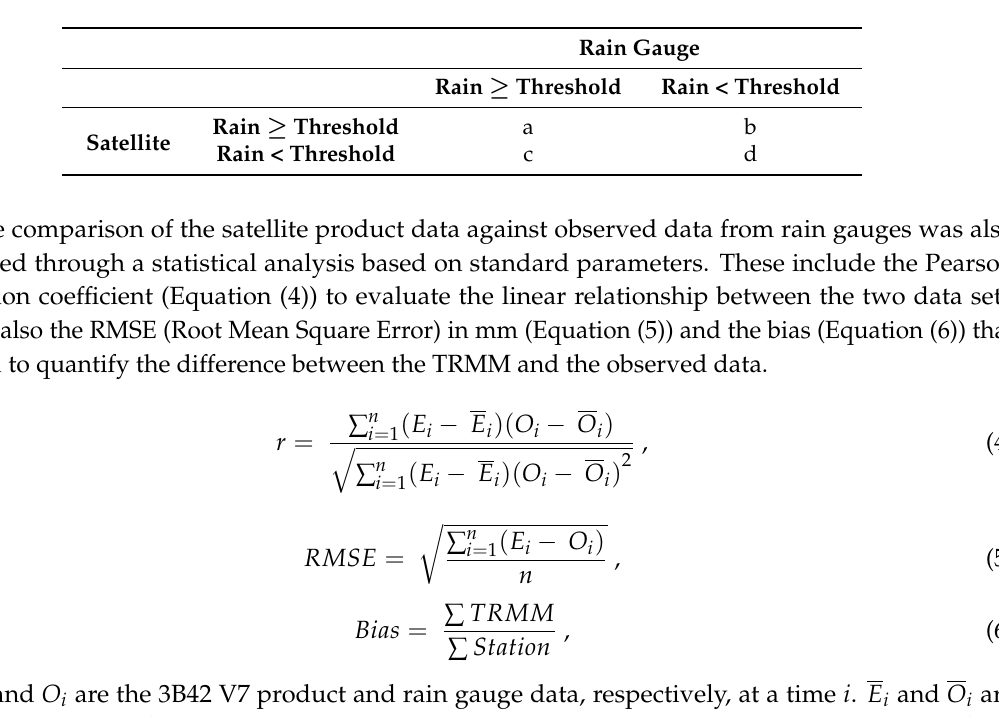
Table 1. Contingency table showing the meaning of parameters used in Equations (1)–(3) (rain ≥ threshold → rainy day; rain < threshold → day without